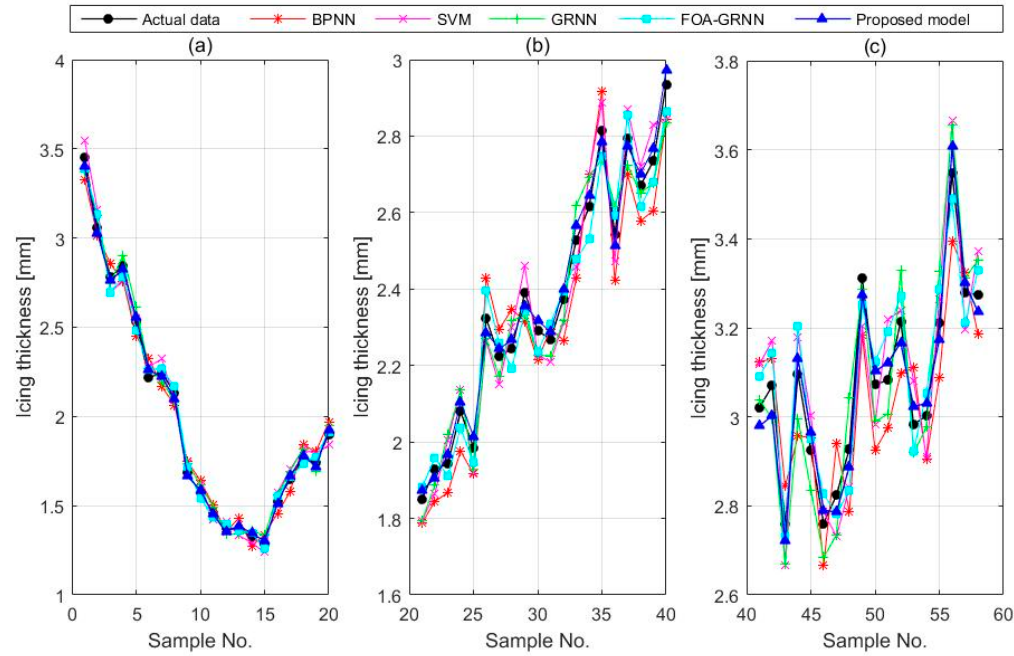
Figure 6. The forecasting values of the proposed method and the comparison methods. Note: ( a ) the forecasting value from sample points 1–20; ( b ) the forecasting value from sample points 20–40; ( c ) the forecasting values from sample points 41–58. BPNN: back-propagation neural network; SVM: support vector machine.